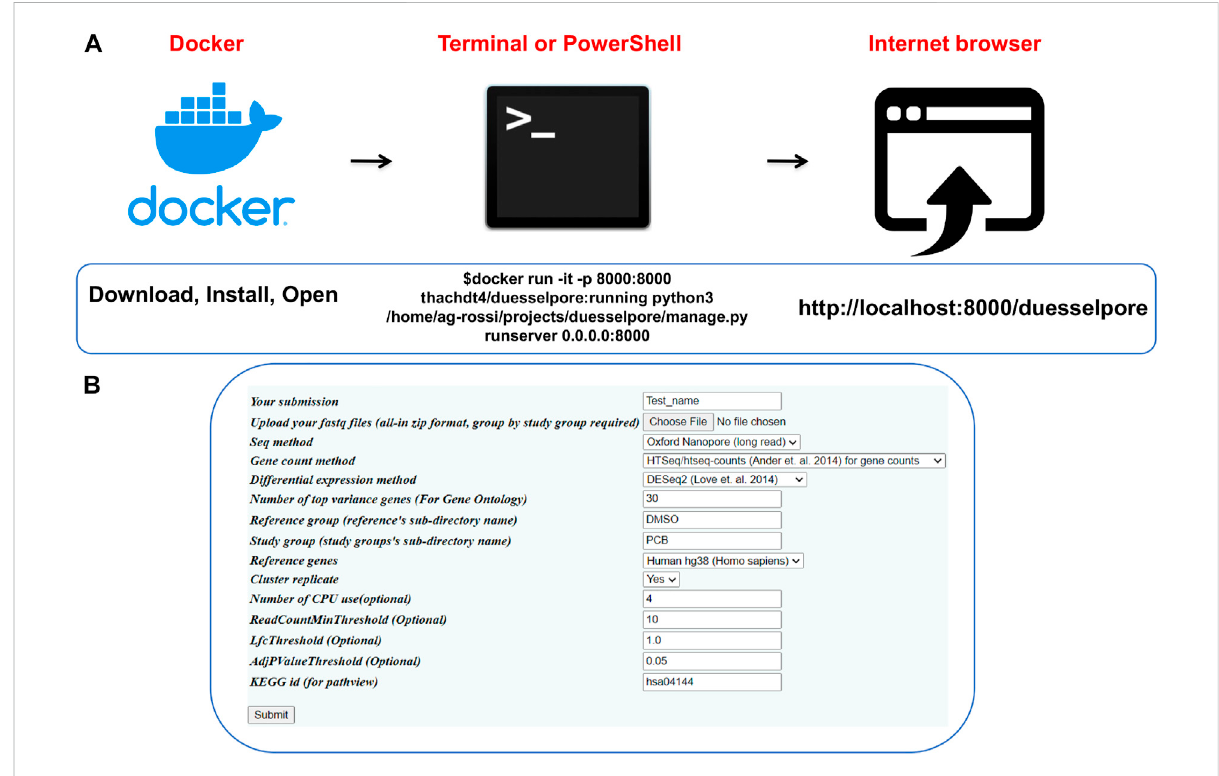
FIGURE 2 Operating Duesselpore. (A) Depicted are the required steps to launch Duesselpore TM on Linux/MacOS (Terminal) or Windows (PowerShell). (B) The interface can be accessed via the user ’ s browser.